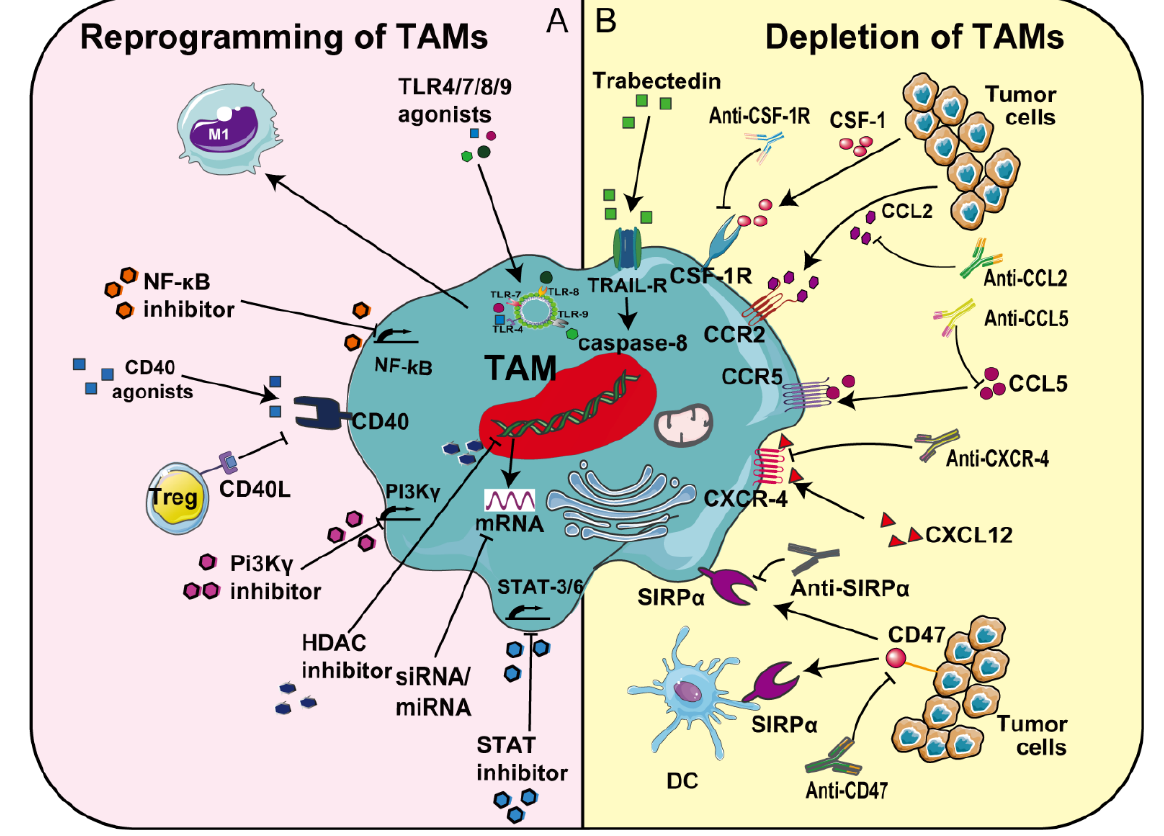
Figure 4. The main strategies for targeting tumor-associated macrophages (TAMs) in cancer therapy. ( A ) TAM repro- gramming is mainly achieved by modulating signaling pathways using agonists of TLRs and CD40, inhibitors of NF- κ B, PI3K γ , STAT and HDAC, and si/miRNA. ( B ) Depletion of TAMs. TAM depletion strategies focus on using anti-neoplastic drugs, such trabectedin, and monoclonal antibodies that block signaling axes, including CCL2/CCR2, CSF-1/CSF-1R, CXCL12/CXCR4, or the interaction of SIRP1 α -CD47. This figure was prepared using a template on the Servier medical art website (http://www.servier.fr/servier-medical-art, accessed on 10 July